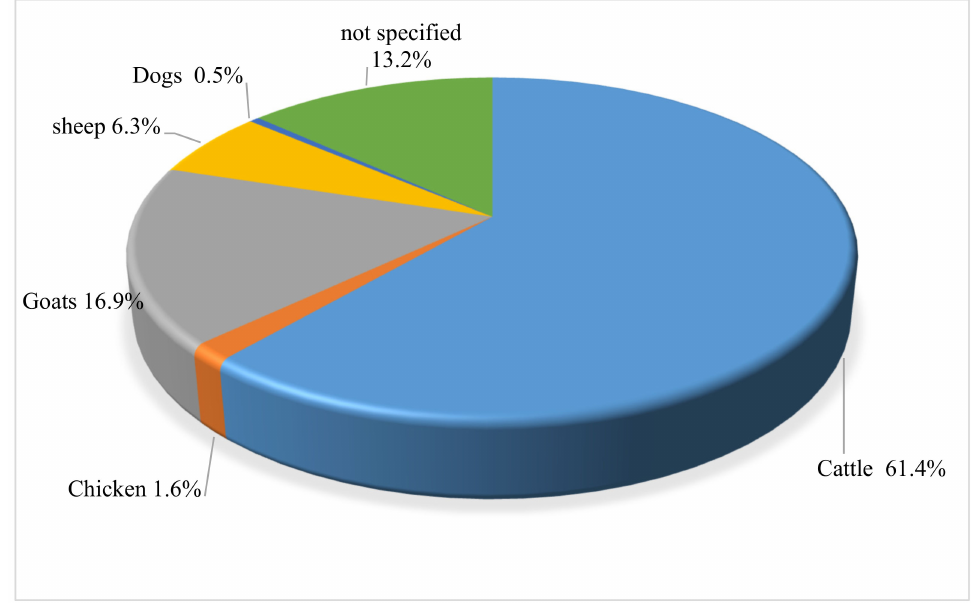
Figure 3. Distribution of animals identified in ethnoveterinary surveys for woody plants in South Africa. ( n =